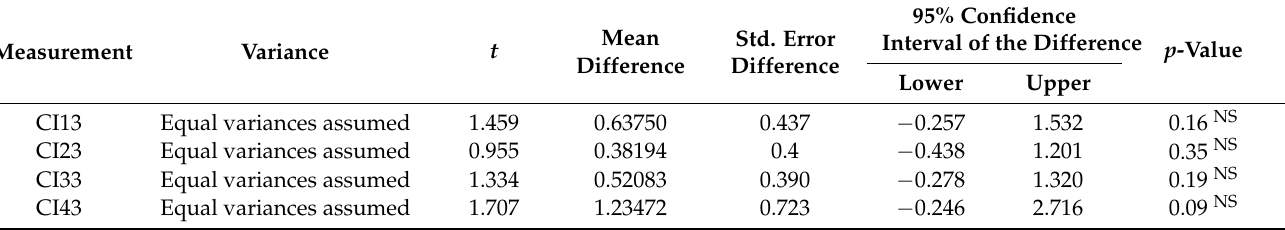
Table 3. The mean difference between two mean using independent sample-t-test for the cervicoincisal of maxillary and mandibular canine.